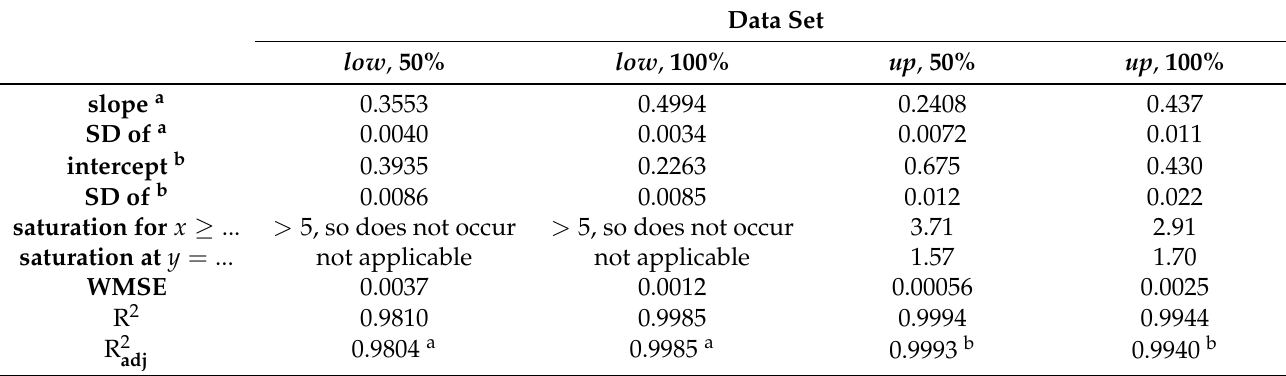
Table 3. Coefficients and statistical parameters of fitted saturated straight lines between moisture of classification products and moisture of input material. low —lower product, up —upper product, 50% and 100%—percentage of nominal throughput of the screw feeder, SD—standard deviation, x –model input, y —model output, WMSE—weighted mean squared error (2),